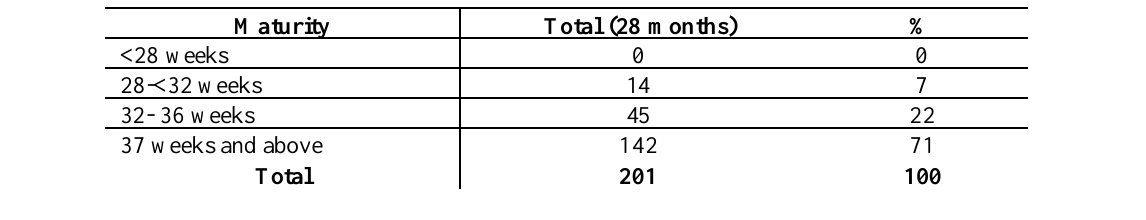
Table II : According to maturity of the babies born at KMCTH and admitted in the SCBU